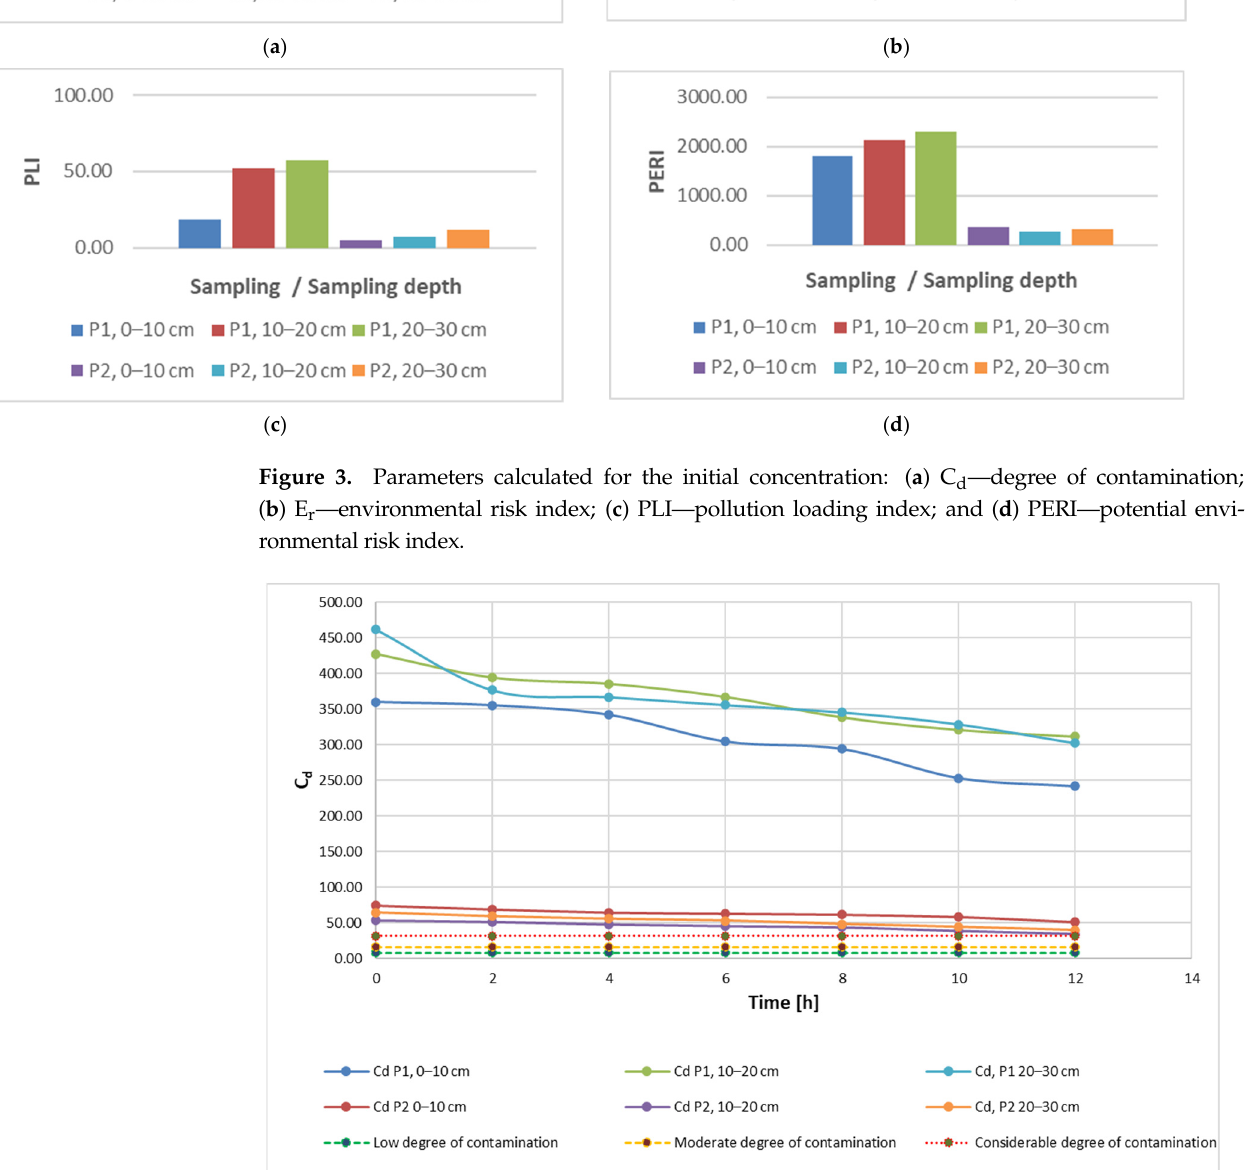
Figure 4. C d —degree of contamination during the extraction process according to admissibility limits and sampling depth using 20 mL 9K medium.